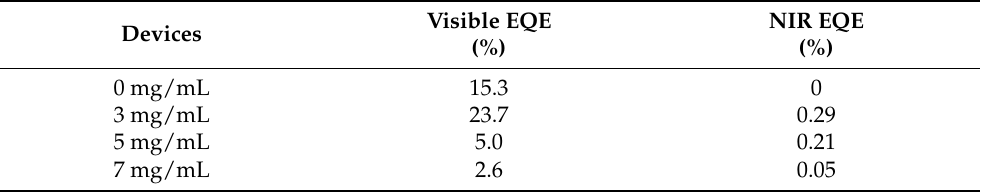
Table 4. External quantum efficiency (EQE) in the visible and NIR region of the